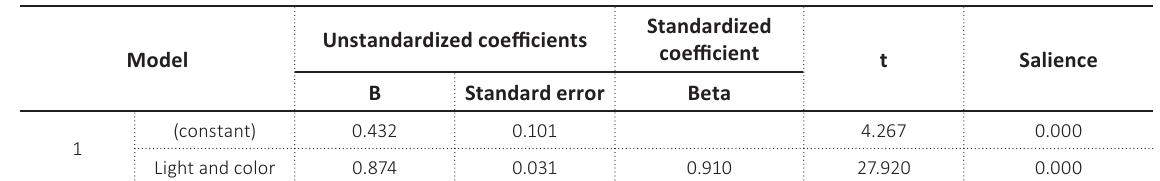
Table 4. Linear regression coefficients of the relationship between light and color and consumers’ purchase intention